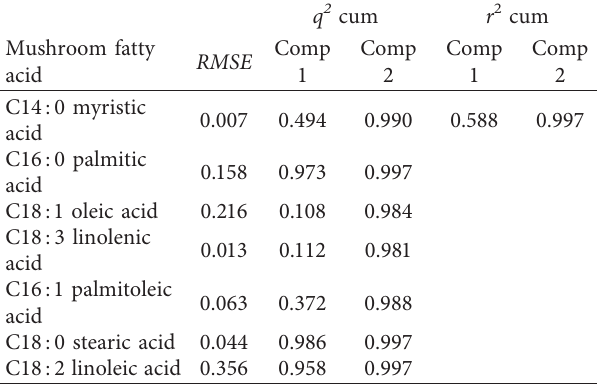
Table 7: Overview of PLSR model for mushroom fatty acids in relation to substrate composition. q 2 cum